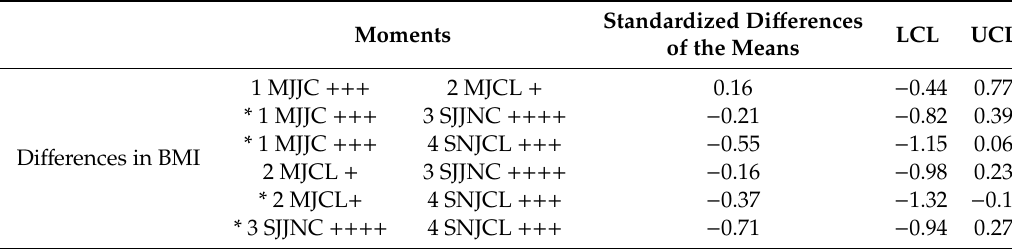
Table 8. Standardized di ff erences of the variable analyzed body mass index at the di ff erent